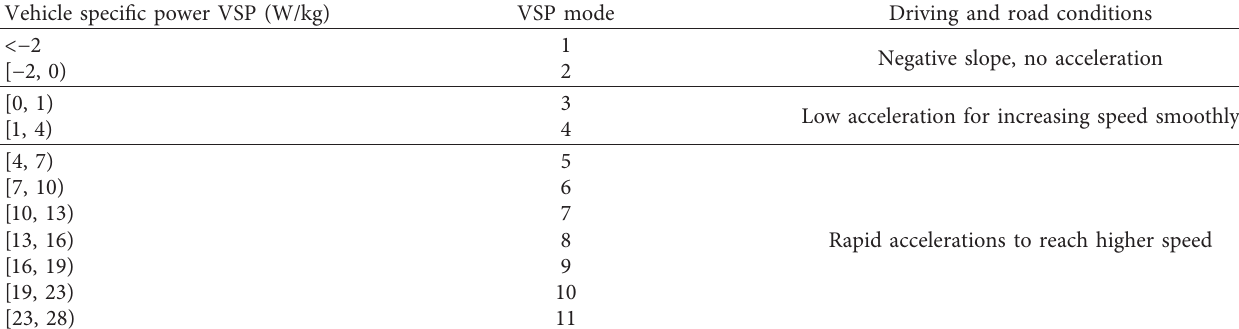
Table 3: Correlation between VSP mode, energy consumption, fuel consumption, and CO